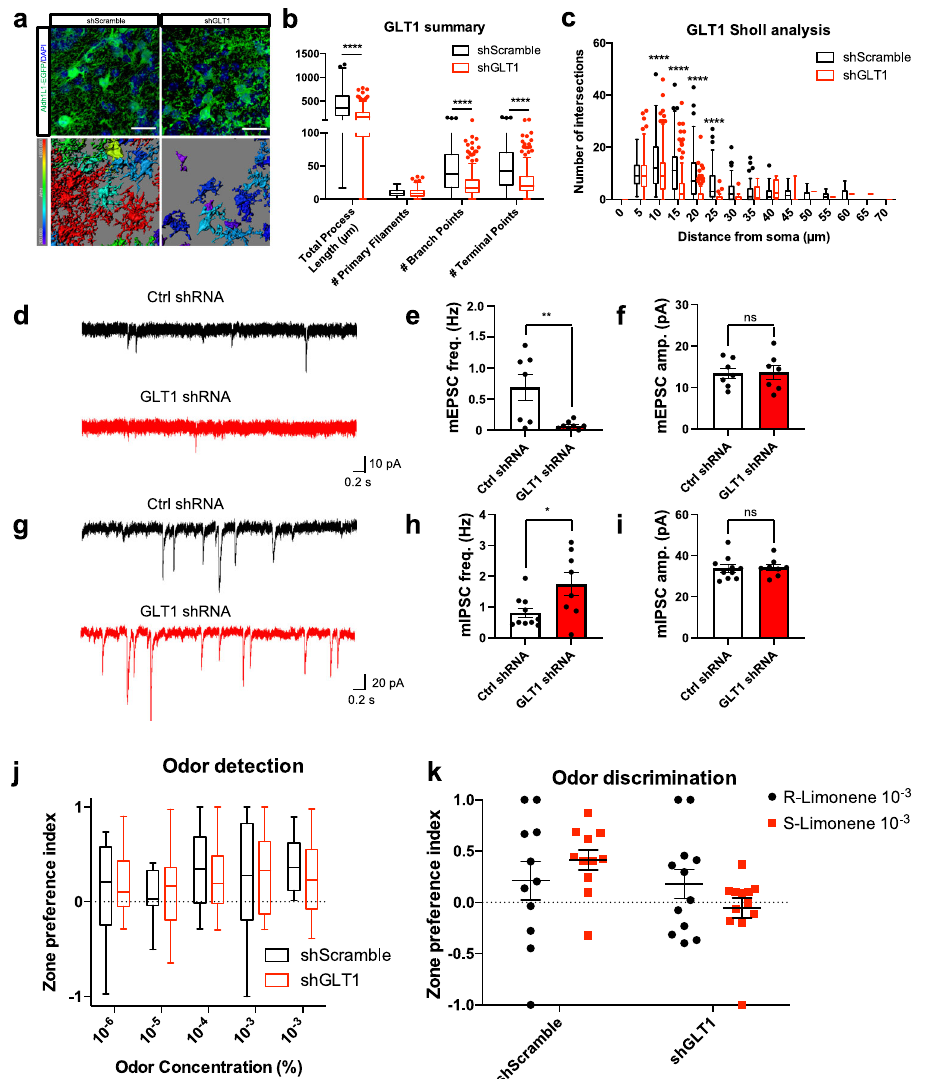
Fig. 6 GLT-1 knockdown partially recapitulates Sox9 KO phenotypes. a – c High-resolution imaging and surface rendering of astrocytes in OB shows a decrease in morphological branching in shGLT1 vs shScramble. n = 256 cells (shGLT1) and n = 138 cells (shScramble) from N = 3 mice, respectively. **** p < 0.0001; 2-way ANOVA with Sidak ’ s multiple comparison correction. Quanti fi cation of ( a ) represented by box plots displaying interquartile range and median with Tukey whiskers. Data are presented as mean values ± SEM. Scale bar, 20 µ m. d Example traces of mEPSC recordings in M/T cells with shScramble control injections (top) and shGLT1 KD injections (bottom). e M/T cells with shGLT1 injections show a signi fi cant decrease in mEPSC frequency compared to control injections. n = 7 cells (shScramble) and n = 7 cells (shGLT1) from N = 4 mice, respectively. ** p = 0.0084. Two-tailed Student ’ s t-test. Data are presented as mean values ± SEM. f M/T cells show no changes in mEPSC amplitude with shGLT1 injections. n = 7 cells (shScramble) and n = 7 cells (shGLT1) from N = 4 mice, respectively. Two-tailed Student ’ s t-test. Data are presented as mean values ± SEM. g Example traces of mIPSC recordings in M/T cells with shScramble control injections (top) and shGLT1 KD injections (bottom). h M/T cells with shGLT1 injections show a signi fi cant increase in mIPSC frequency compared to control injections. n = 10 cells (shScramble) and n = 7 cells (shGLT1) from N = 4 mice, respectively. * p = 0.0257. Two-tailed Student ’ s t-test. Data are presented as mean values ± SEM. ( i ) M/T cells show no changes in mIPSC amplitude with Sox9 KO in astrocytes. n = 10 cells (shScramble) and n = 7 cells (shGLT1) from N = 4 mice, respectively. Data are presented as mean values ± SEM. j Quanti fi cation of 3 compartment place preference assay. n = 12 (shGLT1) and n = 11 (shScramble). Two-way RM ANOVA with Bonferroni ’ s multiple comparison test (main effect of group, F(1,21) = 0.0002768, p = 0.9869; group X concentration interaction, F(4,84) = 0.2148, p = 0.9295). Data are presented as box plots displaying interquartile range and median with Tukey whiskers. k Whisker plot quantifying three chamber place preference during odor discrimination. n = 12 (shGLT1) and n = 11 (shScramble). Two-way RM ANOVA with Bonferroni ’ s multiple comparison test (main effect of